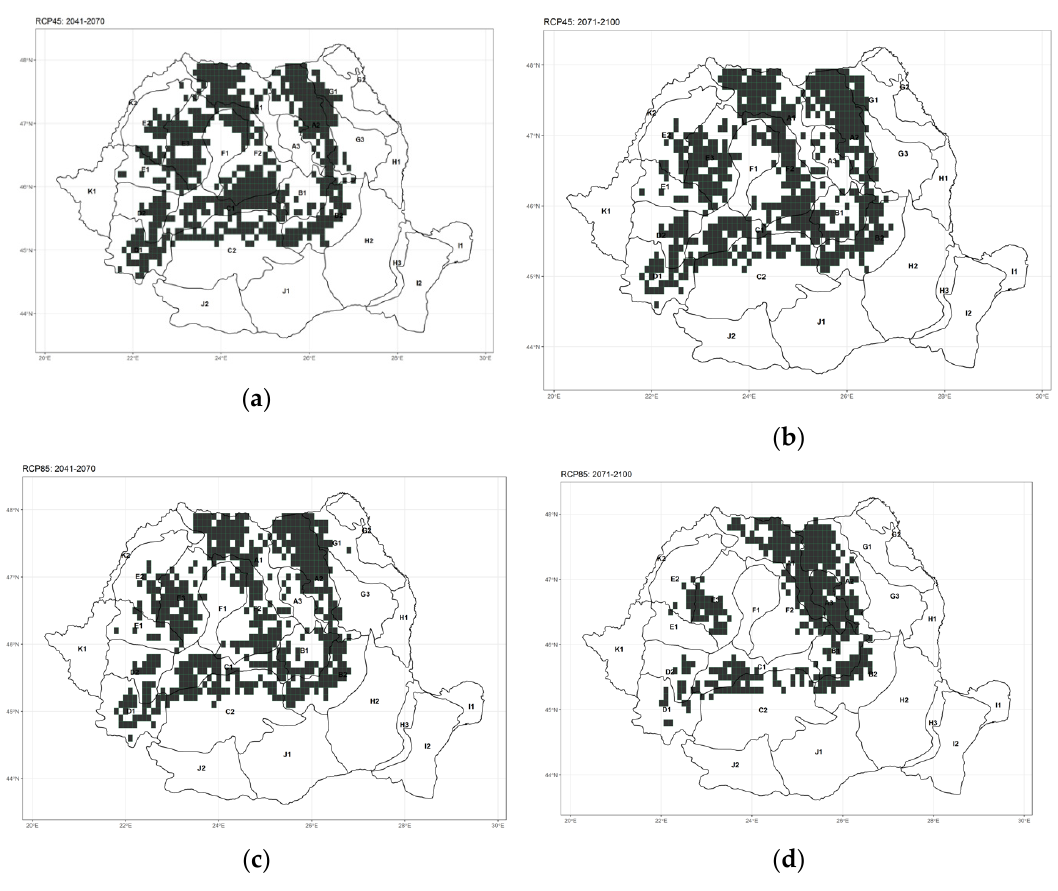
Figure 9. Projected suitability areas for the Douglas fir in Romania under the RCP4.5 ( a , b ) and RCP8.5 ( c , d ) scenarios, over the periods 2041–2070 ( a , c ) and 2071–2100 ( b , d ). The polygons denote various regions of provenance (as defined by [49]). A1: Eastern Carpathians, western cline; A2: Eastern Carpathians, eastern cline; A3: Giurgeu–Ciuc depression; B1: Brasov depression; B2: